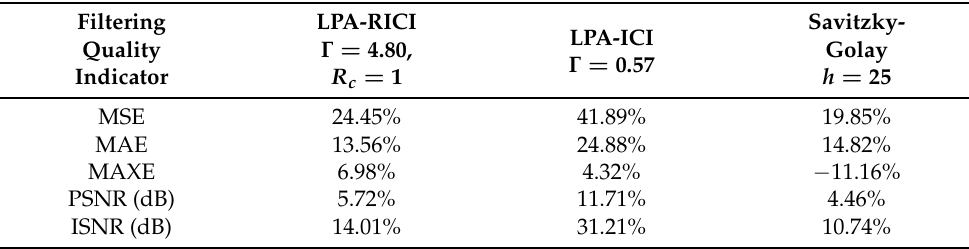
Table 32. Piece-Regular signal (SNR = 5 dB)—Filtering quality improvement of the RBF-RICI-based filtering over other tested algorithms.